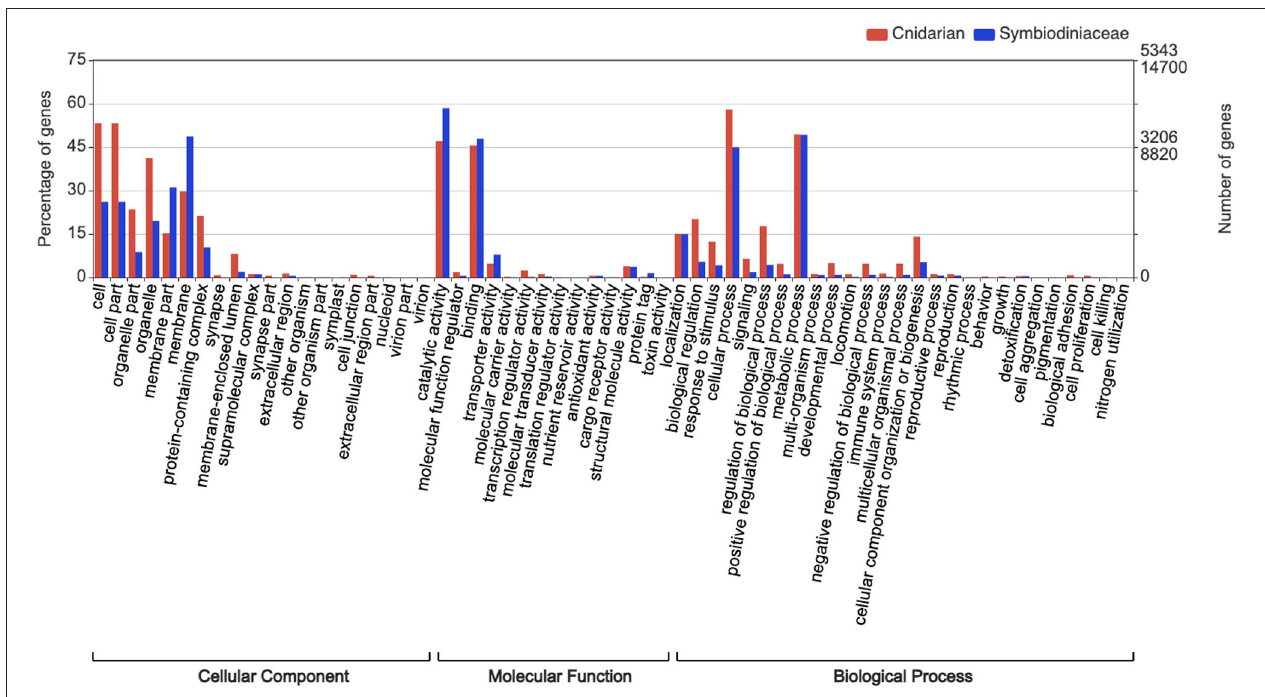
FIGURE 2 | Gene ontology analysis assigned to M. complanata and